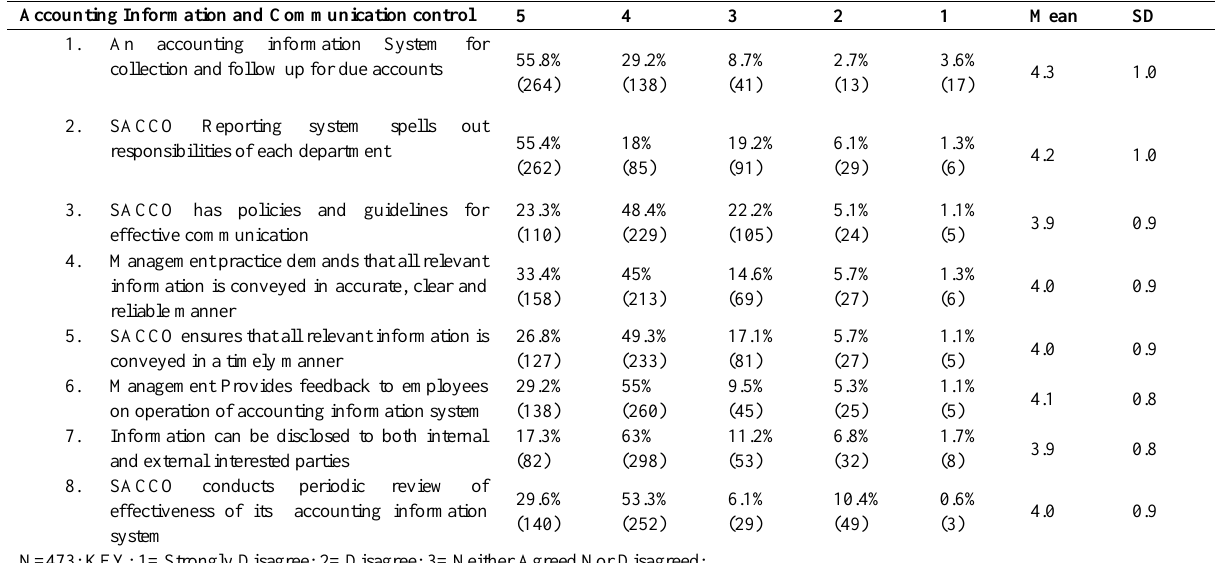
Table 1: Descriptive Results for Accounting Information and Communication